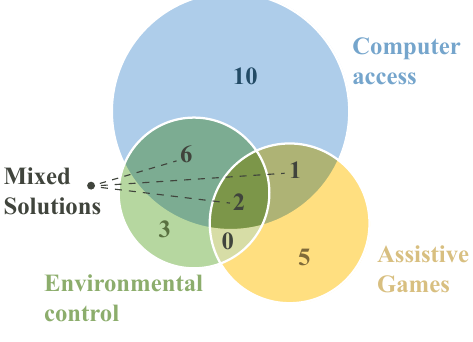
Figura 5. Works grouped by